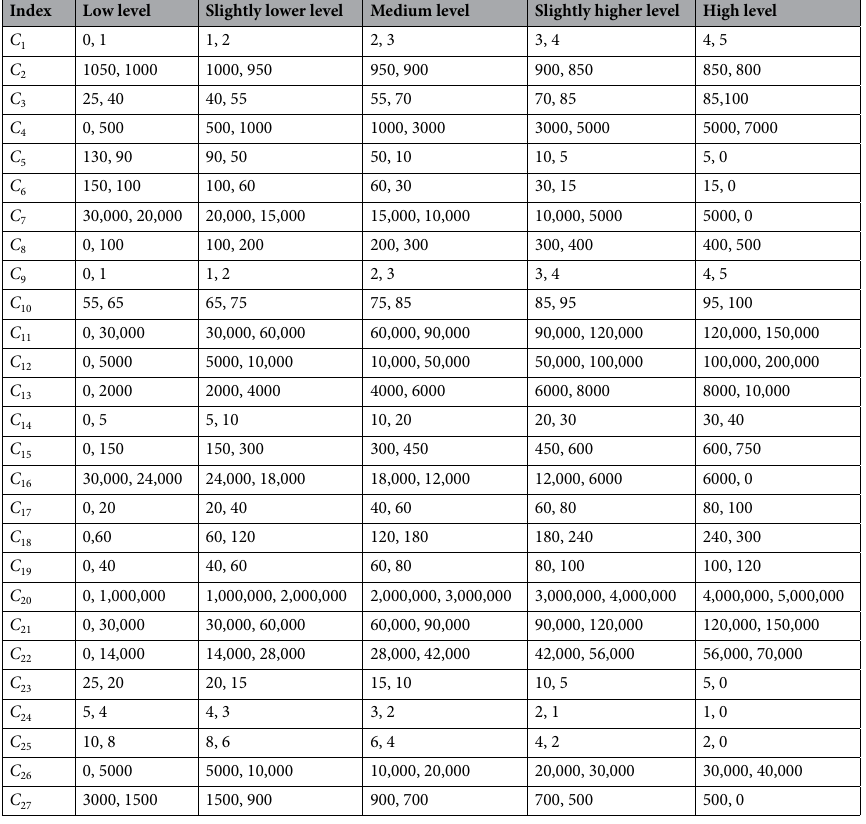
Table 8. Toughness evaluation index